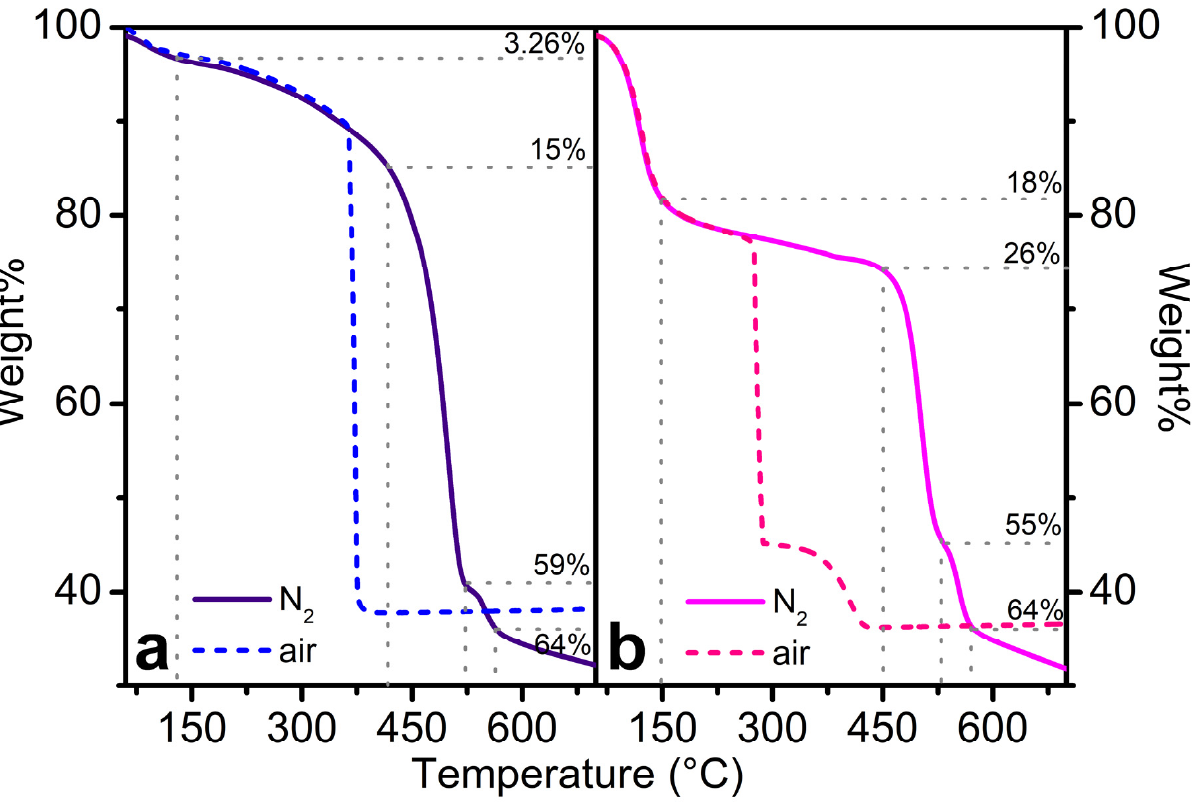
Figure 4. TG traces of ( a ) KCL-102 and ( b ) KCL-102-air in a flow of dry air and N 2 .